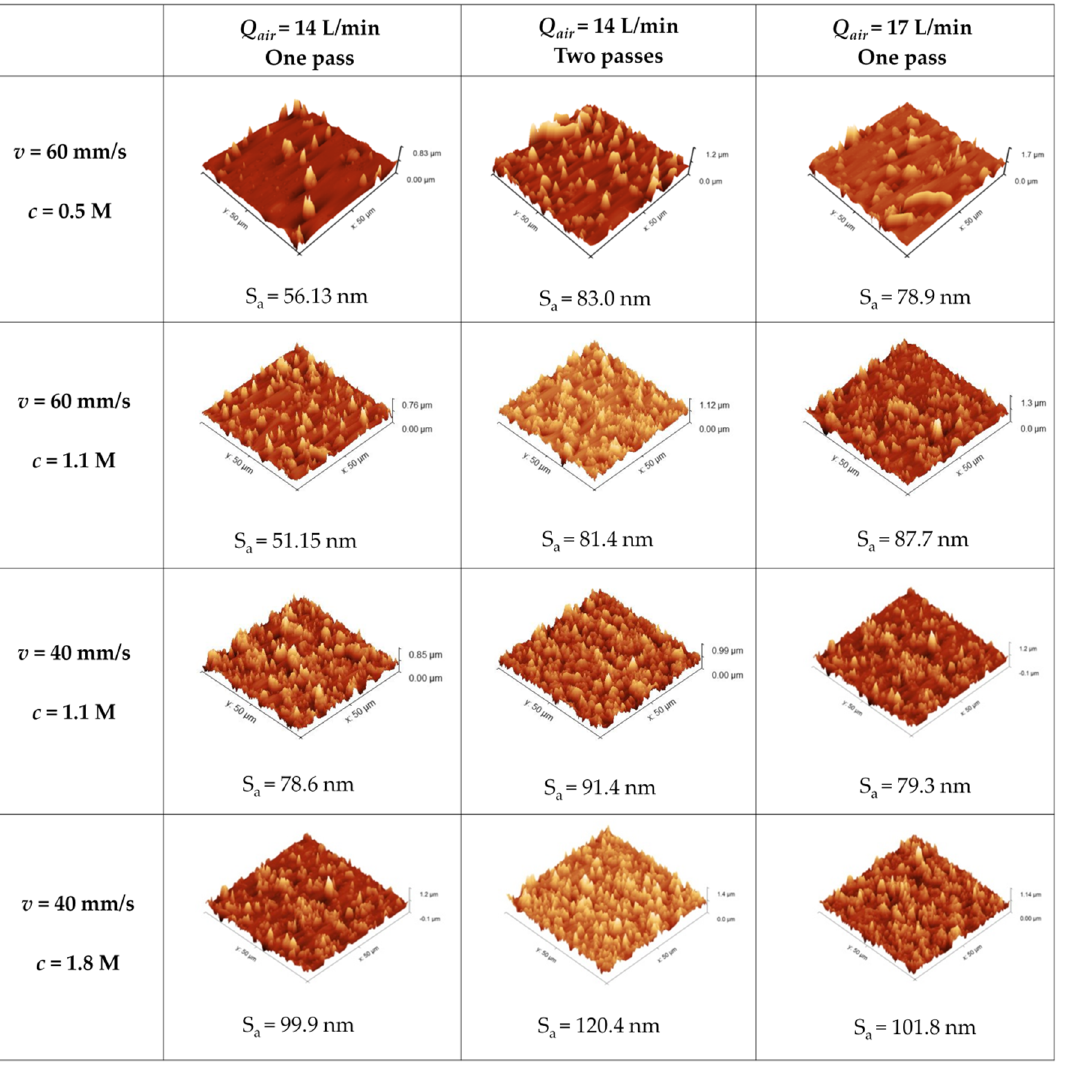
Figure 3. Three-dimensional atomic force microscopy (AFM) images of the coated glass surfaces at different deposition parameters.